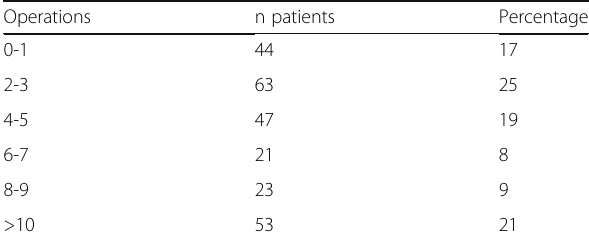
Table 4 Post-injury surgery Operations